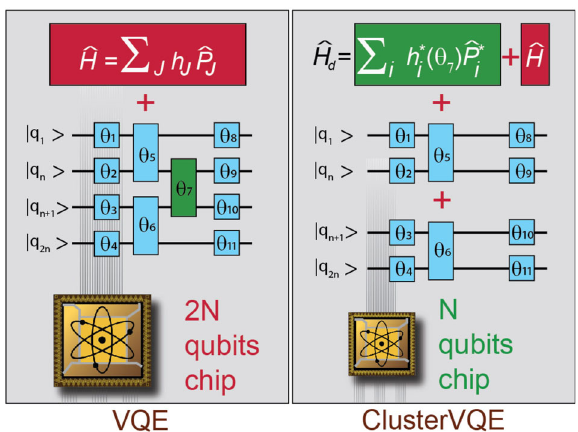
Fig. 7 Finding the lowest eigenvalue of a given qubit Hamiltonian P ̂ H ¼ ̂ P J with VQE and ClusterVQE, where 2 N is the number of J qubits. VQE uses a quantum circuit de fi ned on 2N qubits. In contrast, ClusterVQE splits the original 2N-qubit circuit into 2 N-qubit circuits by removing the entanglement between them. Here, shorter circuits are achieved at the expense of a dressed Hamiltonian ^ H d